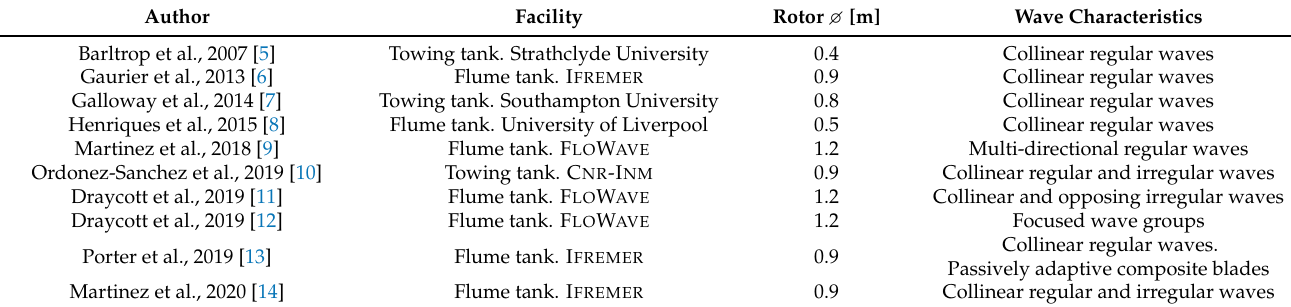
Table 1. Wave–current interaction experiments undertaken with three-bladed